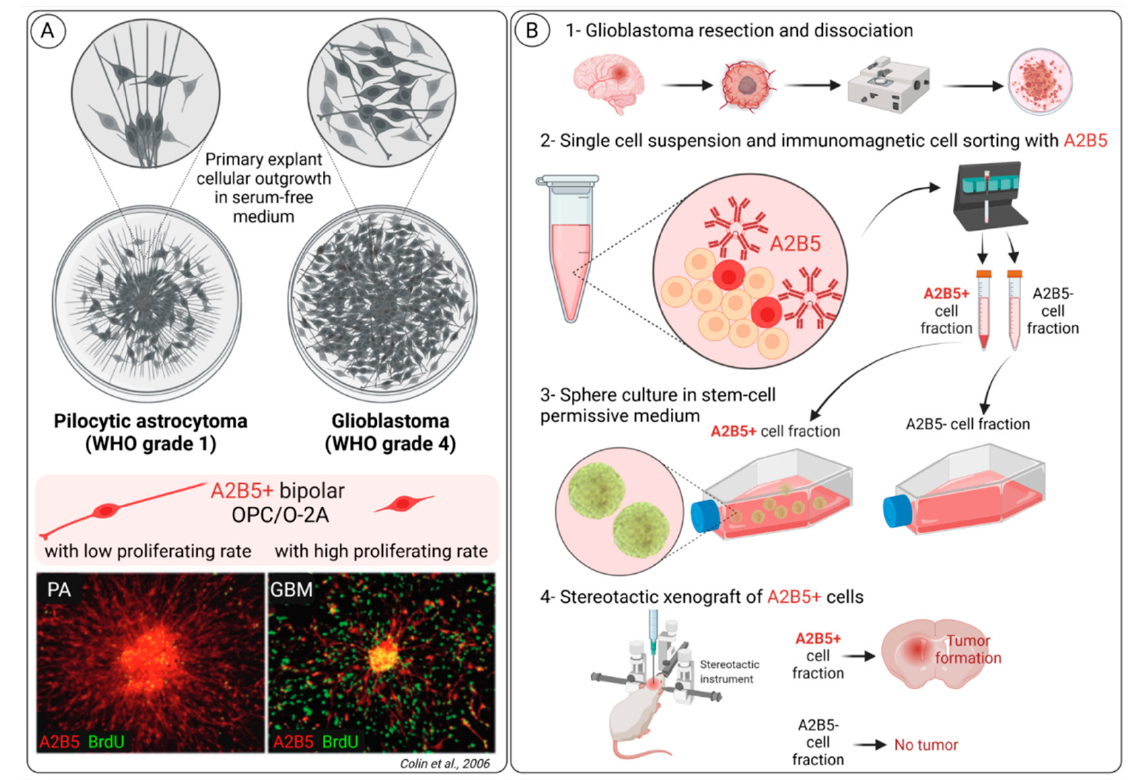
Figure 4. Overview of A2B5 expression in glioma highlighting A2B5 as a GBM CSC marker. ( A ) A2B5+ bipolar OPC/O-2A cells are observed in all glioma types but harbor distinct migration and prolif- eration capacities, depending on the WHO grade of glioma (pilocytic astrocytoma—PA, grade 1, versus glioblastoma—GBM, grade 4). In primary explant culture assays, A2B5+ cells from PA did not proliferate (few A2B5+/BrdU+ cells); they had a bipolar appearance with very long cell processes, one of them being in close contact with the explant. In contrast, A2B5+ cells from GBM migrated far away from the explant and were dividing (numerous A2B5+/BrdU+ cells). ( B ) We and others have generated A2B5+ cancer stem cell GBM cell lines; here we summarize our procedure, from (1) tumor resection and mechanic and enzymatic dissociation, (2) A2B5 immunomagnetic cell sorting (A2B5+ cell fraction was about 20% of the single cell suspension), (3) culture in a serum free stem-cell permissive medium to form gliomaspheres and (4) demonstration that only A2B5+ cell fraction gives rise to tumor development after stereotactic xenograft in